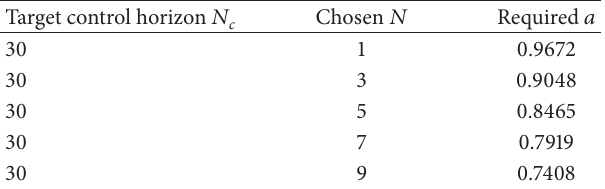
Target control horizon 𝑁 𝑐 Chosen 𝑁 Required